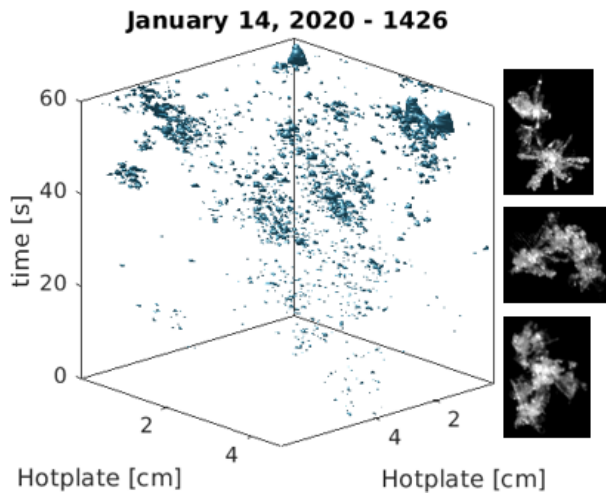
Figure B3. As for Fig. B1 but for aggregate snow.